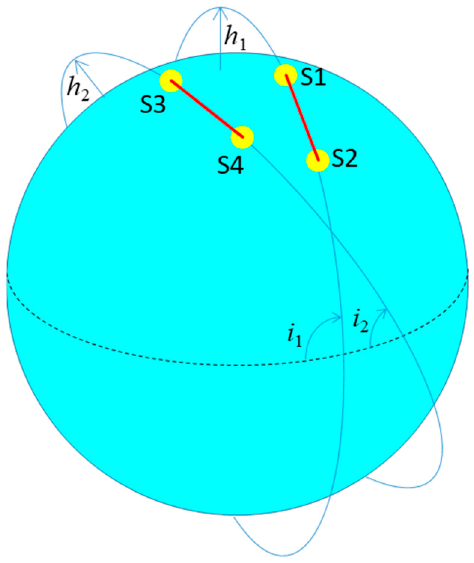
Figure 2. Arrangement of two satellite pairs (S1-S2, S3-S4) in “Bender Constellation”.